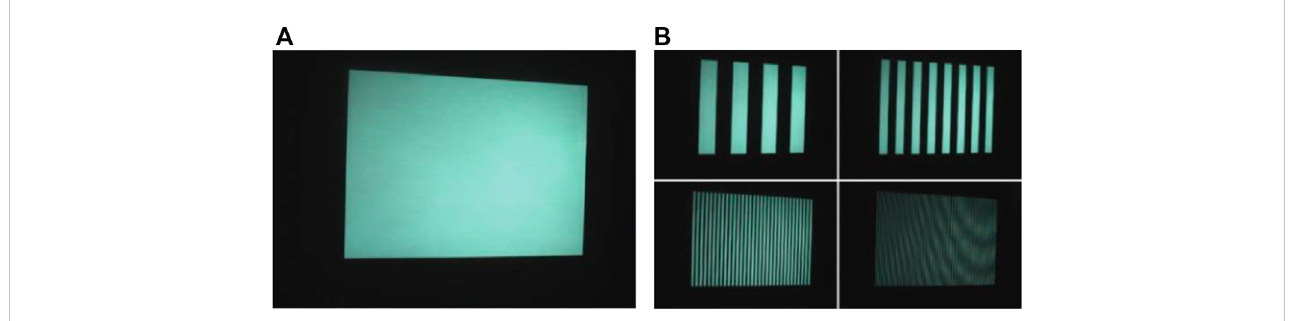
FIGURE 9 The measured plane and its encoding pattern. (A) Measured plane; and (B) Coding plan.